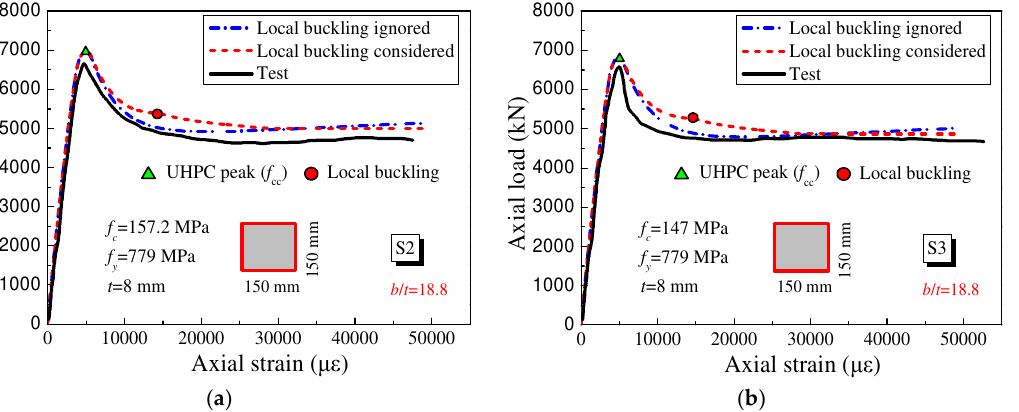
Figure 7. The comparisons of predicted N- ε curves with test results (Xiong et al. [34]). ( a ) S2 ( b ) S3.